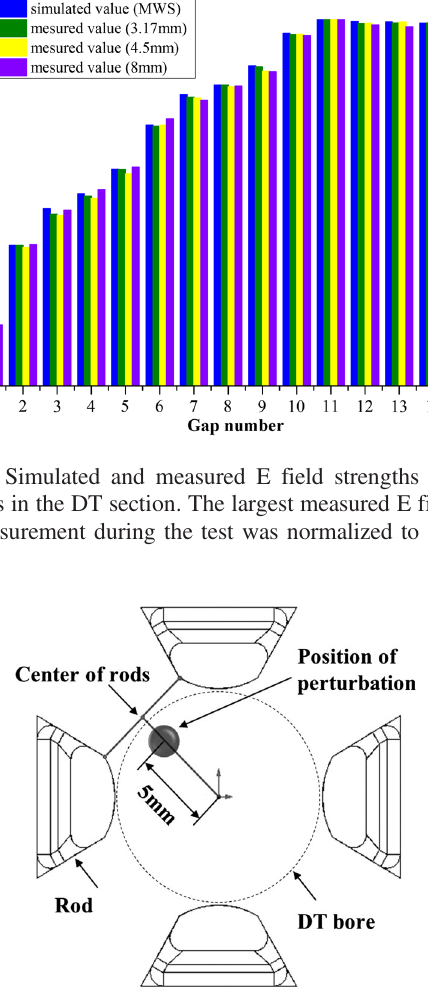
FIG. 4. An image of the new perturbation position for meas- uring the E field strength between interrods.